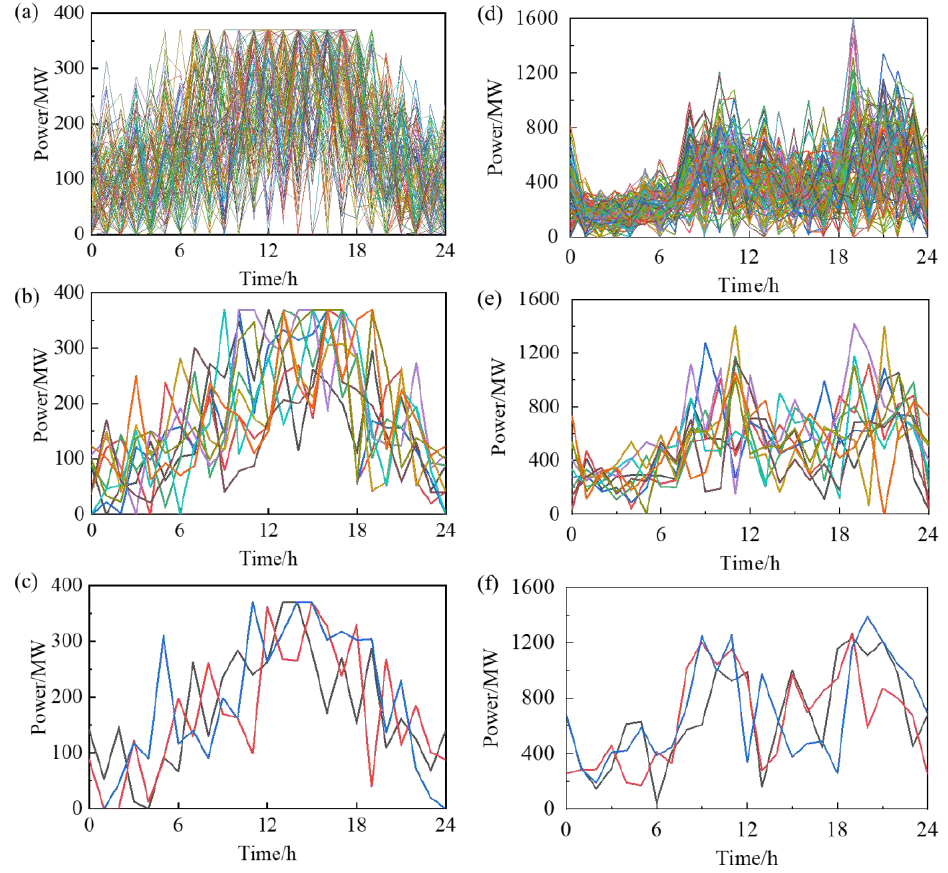
Figure 6. Scenario reduction process, regarding wind power and load scenarios: ( a ) 100 scenarios of wind power; ( b ) 10 scenarios of wind power; ( c ) 3 scenarios of wind power; ( d ) 100 scenarios of load; ( e ) 10 scenarios of load; and ( f ) 3 scenarios of load.